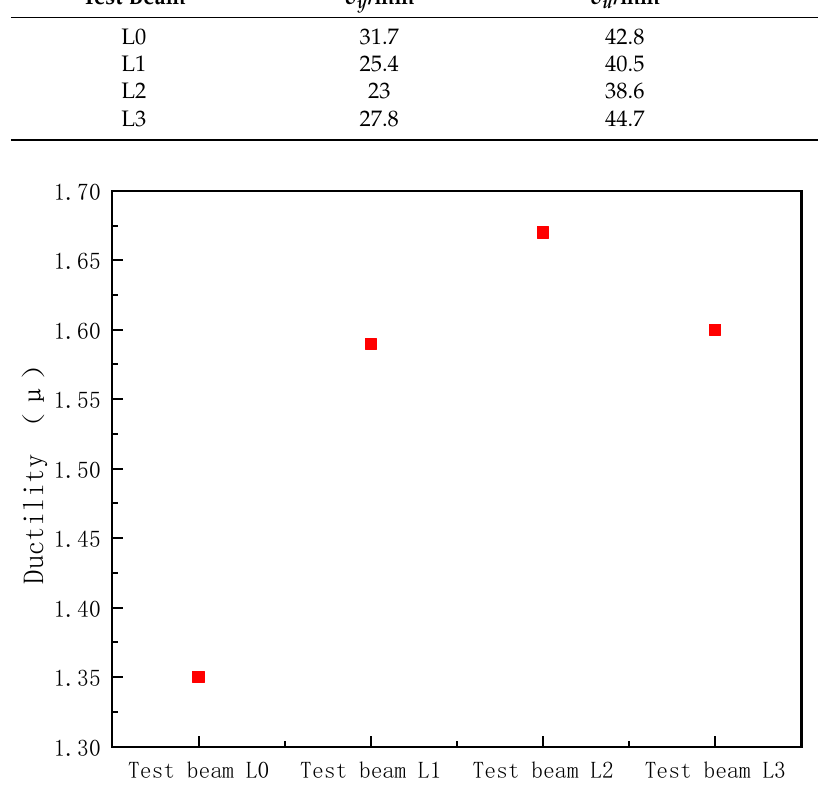
Figure 13. Ductility of each test beam.